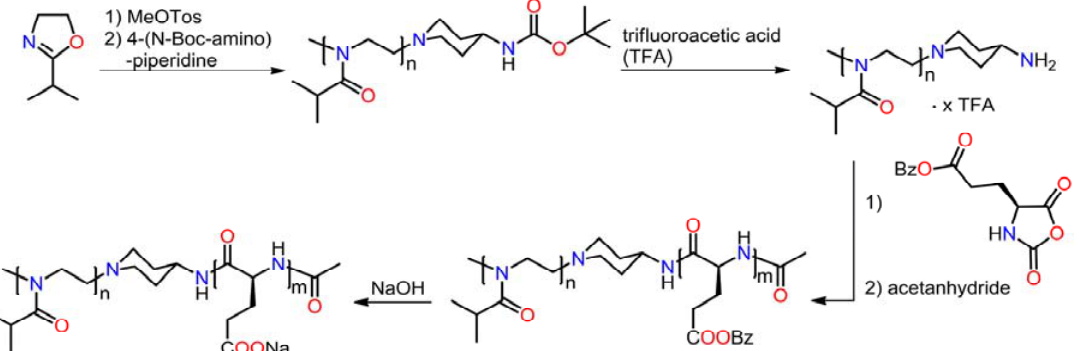
of the diblock copolymer p i PrOx- block -poly( L -glutamate) involving amine-functionalized p i PrOx macroinitiators and N -carboxyanhydride protected L -glutamic acid (for details, see reference